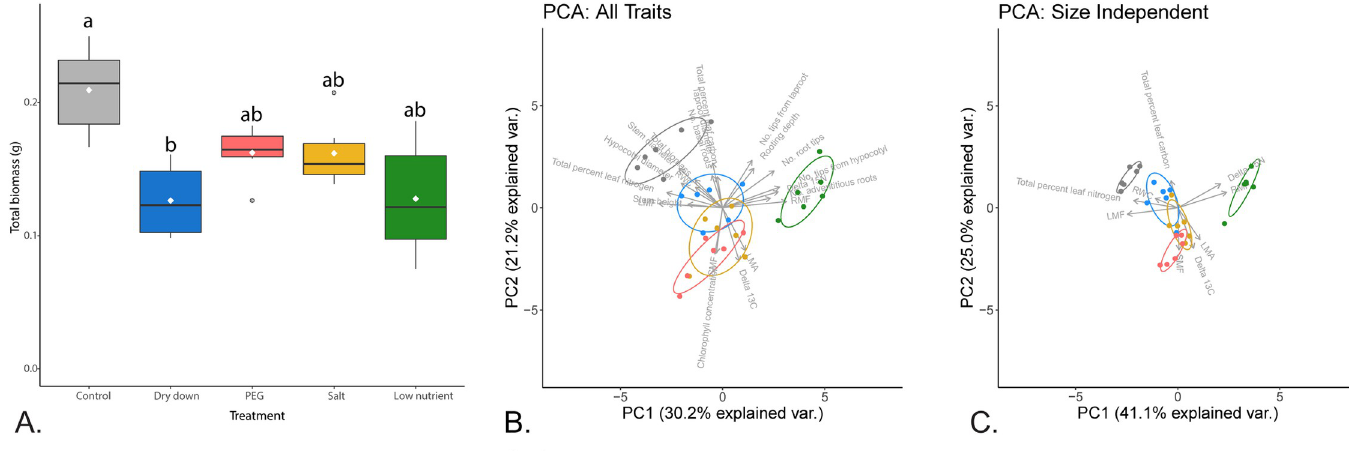
Fig 1. Phenotypic trait comparison for control vs. stress scenarios. In all panels, control is shown in gray, dry-down in blue, PEG in red, salt in yellow, and low-nutrient in green. (A) Boxplot of overall plant performance measured as total biomass. Black horizontal bars indicate median, while white diamonds indicate mean values per treatment. Letters above each box correspond to their post hoc Wilcoxon groupings. (B) Principal component analysis (PCA) for all measured traits (n = 21) illustrated using the first two PCs. (C) PCA of all size-independent traits (n = 10) illustrated using the first two PCs.